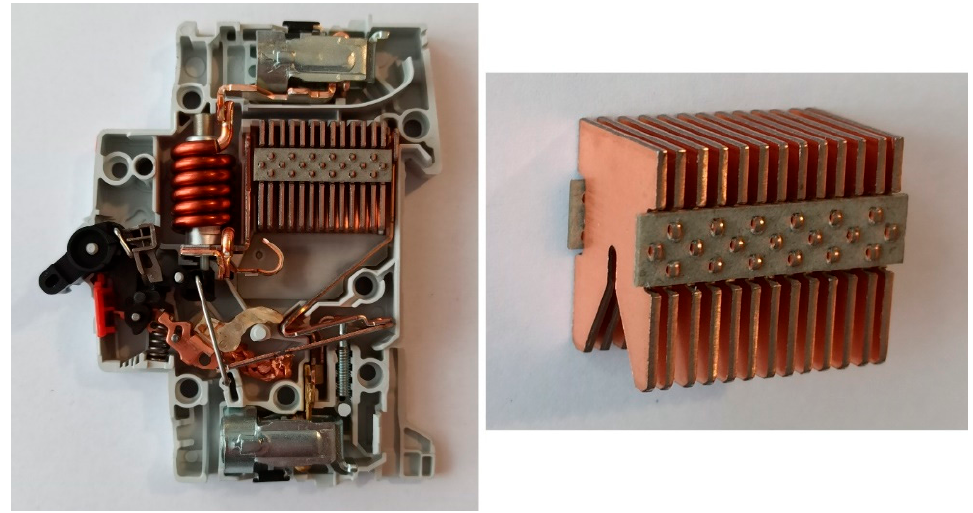
Figure 14. The interior of the tested circuit breaker with ferromagnetic side plates and an extinguish- ing chamber with ferromagnetic plates used as test objects.